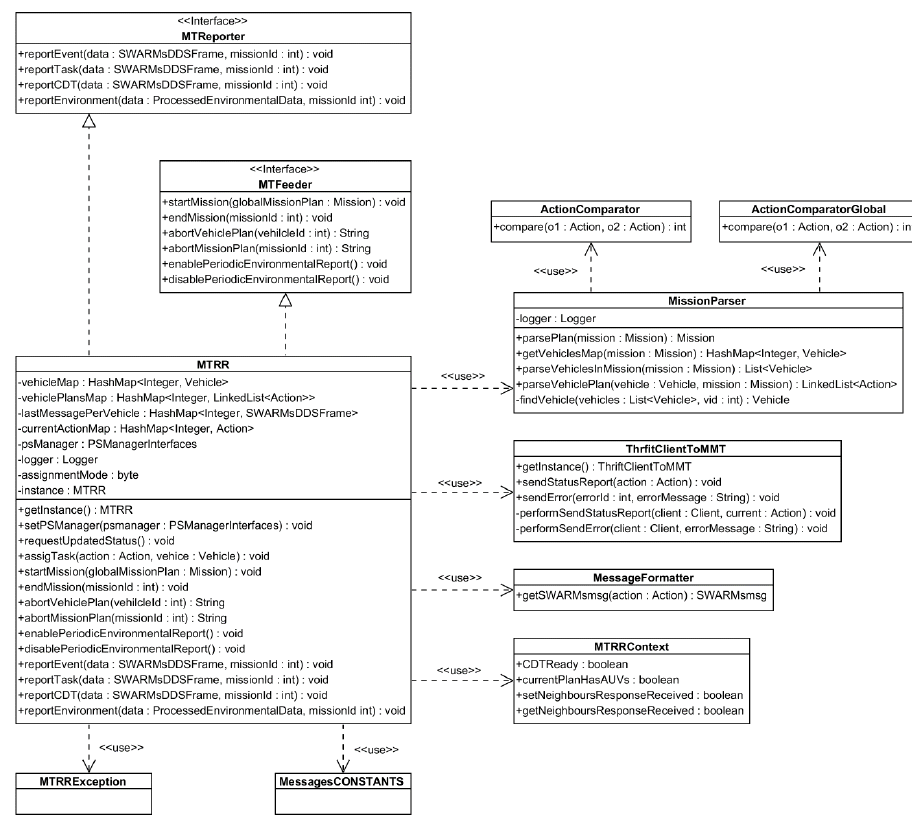
Figure 6. MTRR component class diagram.